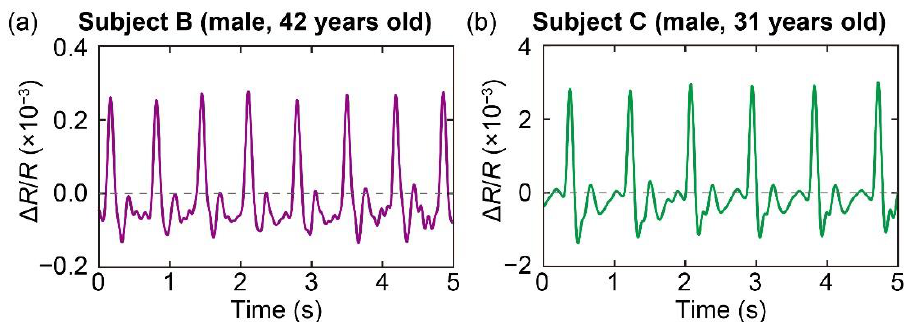
6 of 10 Figure 4. ( a ) Measurement of pulse wave at the tip of the subject’s index finger. ( b ) Measurement of pulse wave at the wrist of the subject. The measurement results for subject B and subject C are shown in Figure 5a,b, respectively. For